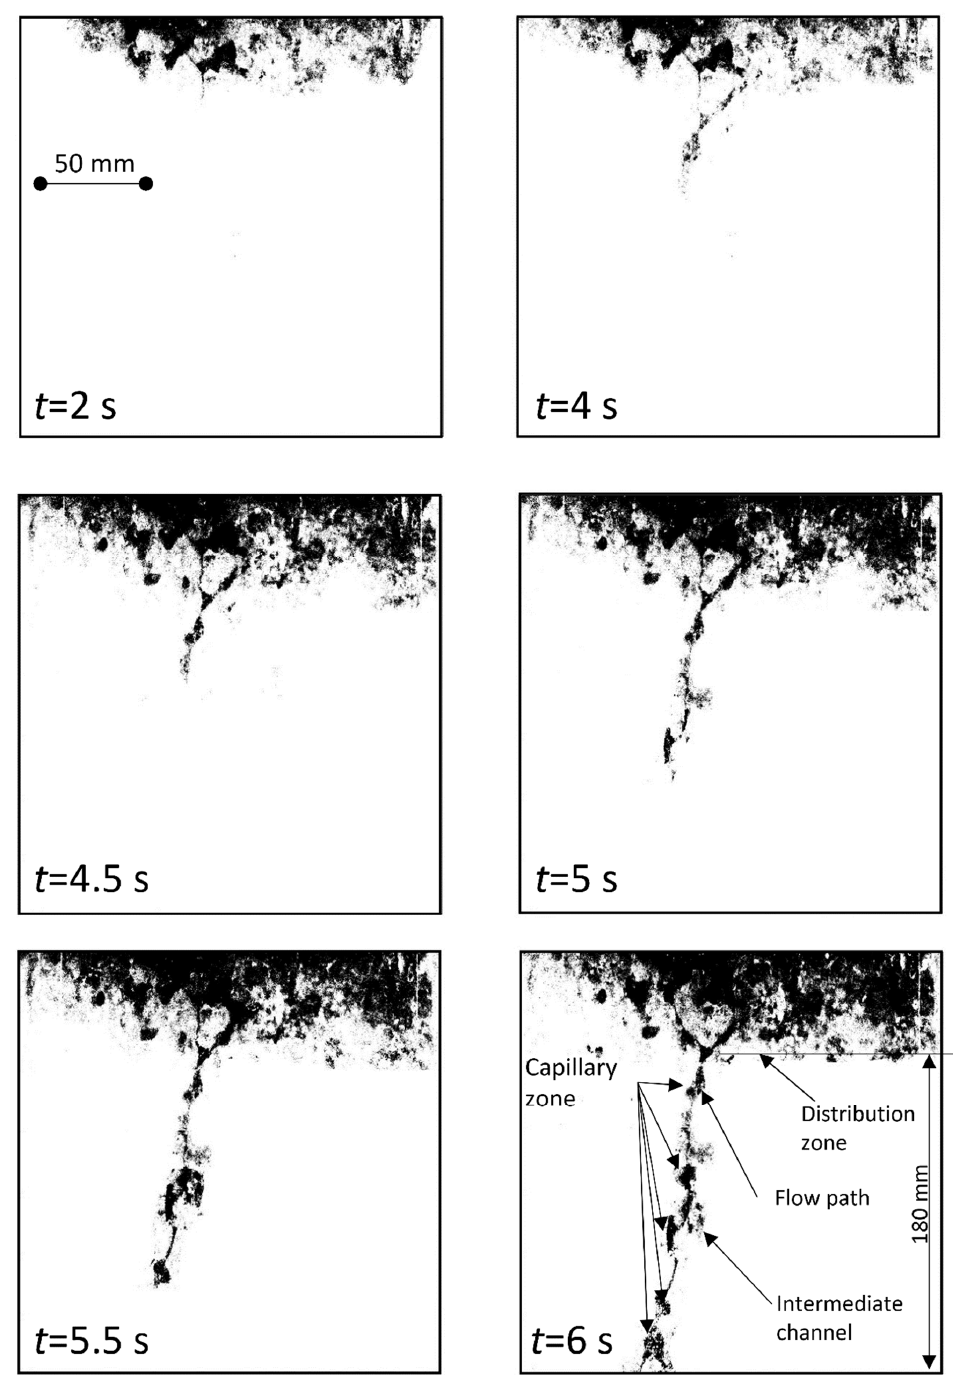
Figure 7. Flow movement through Fracture ‐ 1 for an inclination angle of 45°, under dry initial conditions.